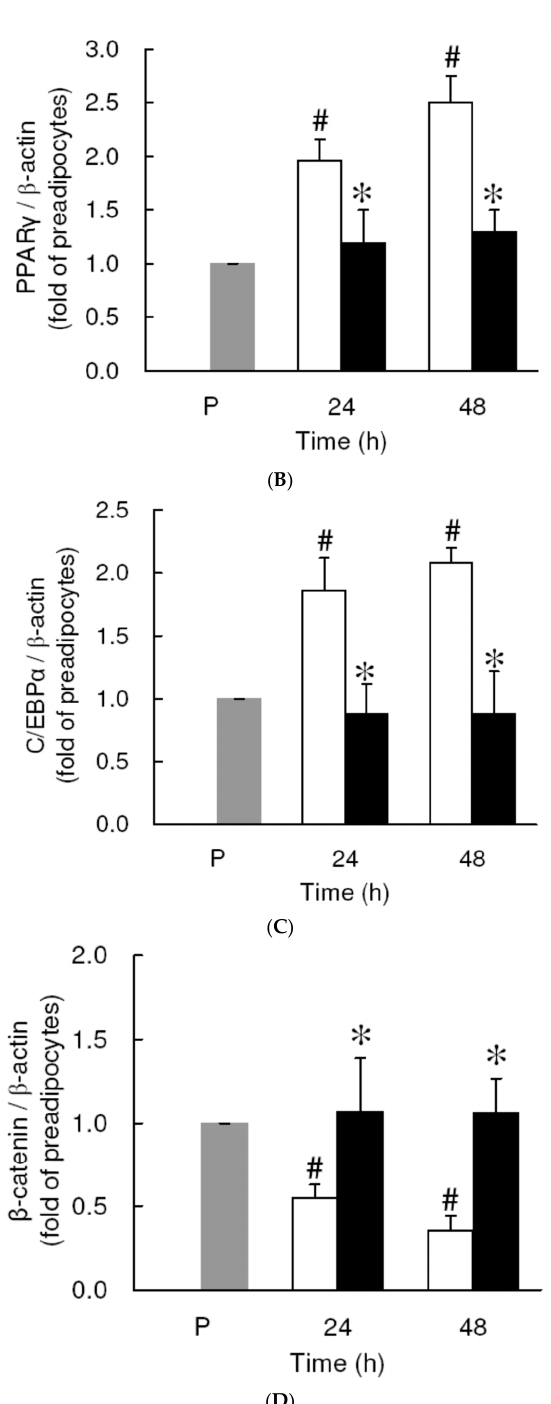
Figure 6. Low dose curcumin alters the expressions of adipogenic proteins during adipocyte Figure 2. High-dose curcumin induces apoptosis in 3T3-L1 preadipocytes. ( A – C ) 3T3-L1 di ff erentiation. 3T3-L1 preadipocytes were incubated for 1 h with medium alone ( ) or with 15- µ M preadipocytes were left untreated (  ) or were incubated with 30 μ M curcumin (  ) for 24 ( B – C ) or 48 h ( B , C ), then cell apoptosis was examined by TUNEL staining (blue fluorescence DAPI curcumin ( (cid:4) ), then adipocyte di ff erentiation was induced in the continued presence or absence of staining of nuclei and green fluorescence TUNEL staining of apoptotic cells) (A) and quantified by curcumin for 24 and 48 h and the expression of the adipogenic proteins PPAR γ , C / EBP α , and β -catenin flow cytometry (B,C). ( D ) Western blots of cleaved caspase 3, 8, and 9 in 3T3-L1 preadipocytes after was measured by immunoblotting, with β -actin as the loading control. A representative blot is shown 24-h incubation in medium alone or medium containing 30 μ M curcumin. In (A), (B), and (D), the results shown are representative of those in four separate experiments. In (C), the results are the mean in ( A ) and the quantitative analysis in ( B – D ). In (A), the results shown are representative of those in ± SD for four independent experiments. * P < 0.05 compared to the vehicle control. four separate experiments. In ( B – D ), the results are the mean ± SD for four independent experiments. P, preadipocytes; * P < 0.05 compared to the vehicle control at the same time. # P < 0.05 compared to the